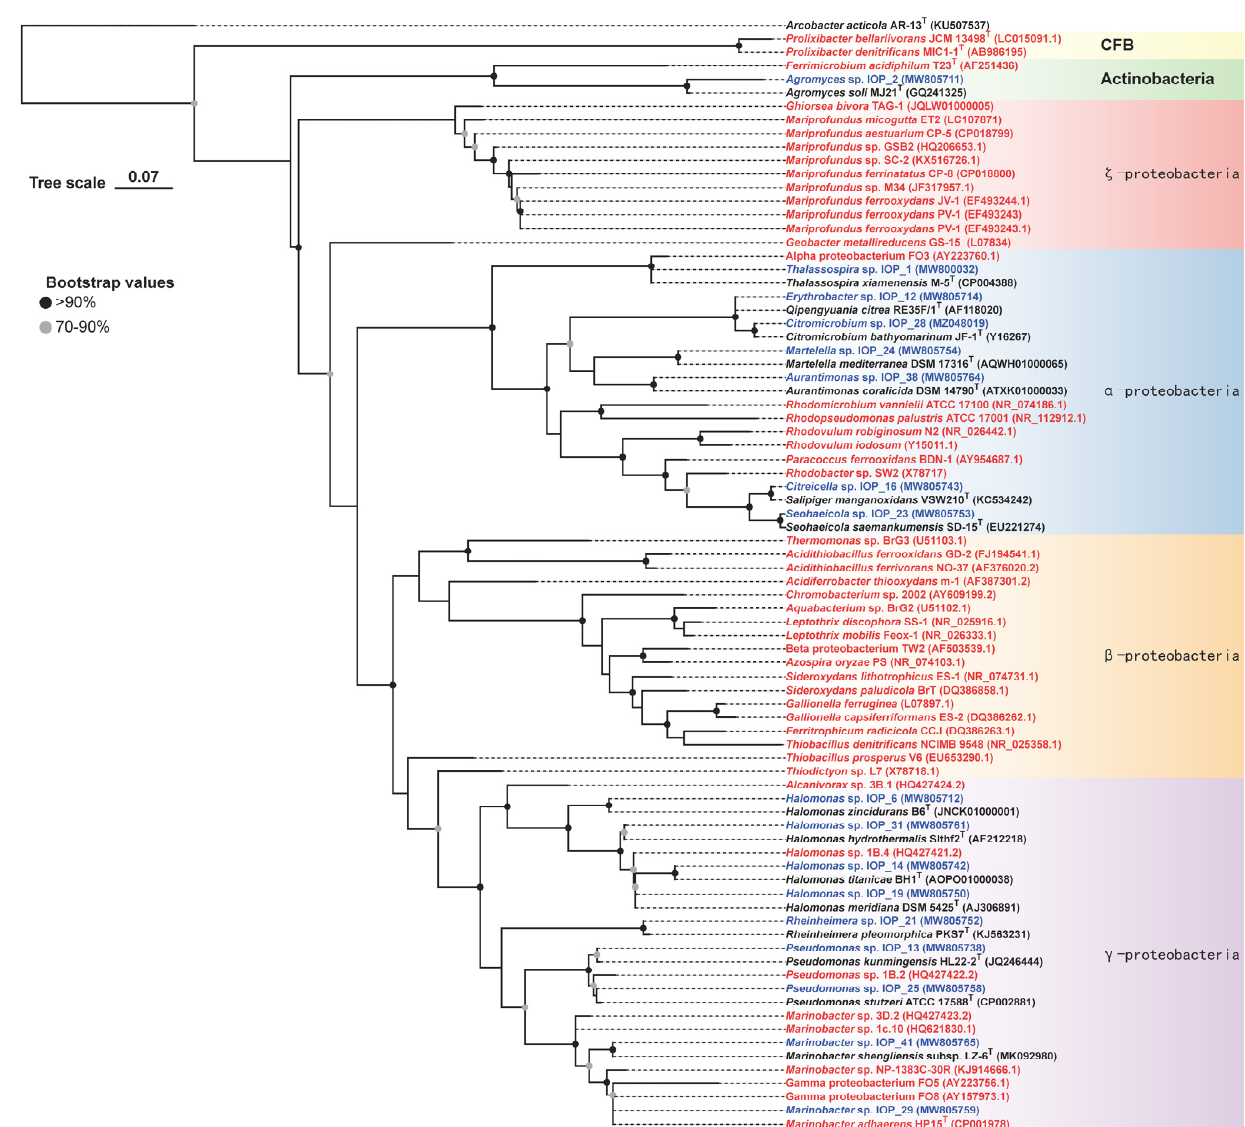
Figure 1. Phylogenetic relationships between cultured strains in this study (blue), reported autotrophic Fe oxidizers (red) and close relatives (black). The tree is a maximum-likelihood tree, based on the small-subunit (16S) rRNA gene (723 bp), showing bootstrap values (out of 1000 replicates). Additionally, seven isolates were affiliated to genera Thalassospira , Qipengyuania , Salip- iger , Seohaeicola , Martelella , Citromicrobium , and Aurantimonas in the class α